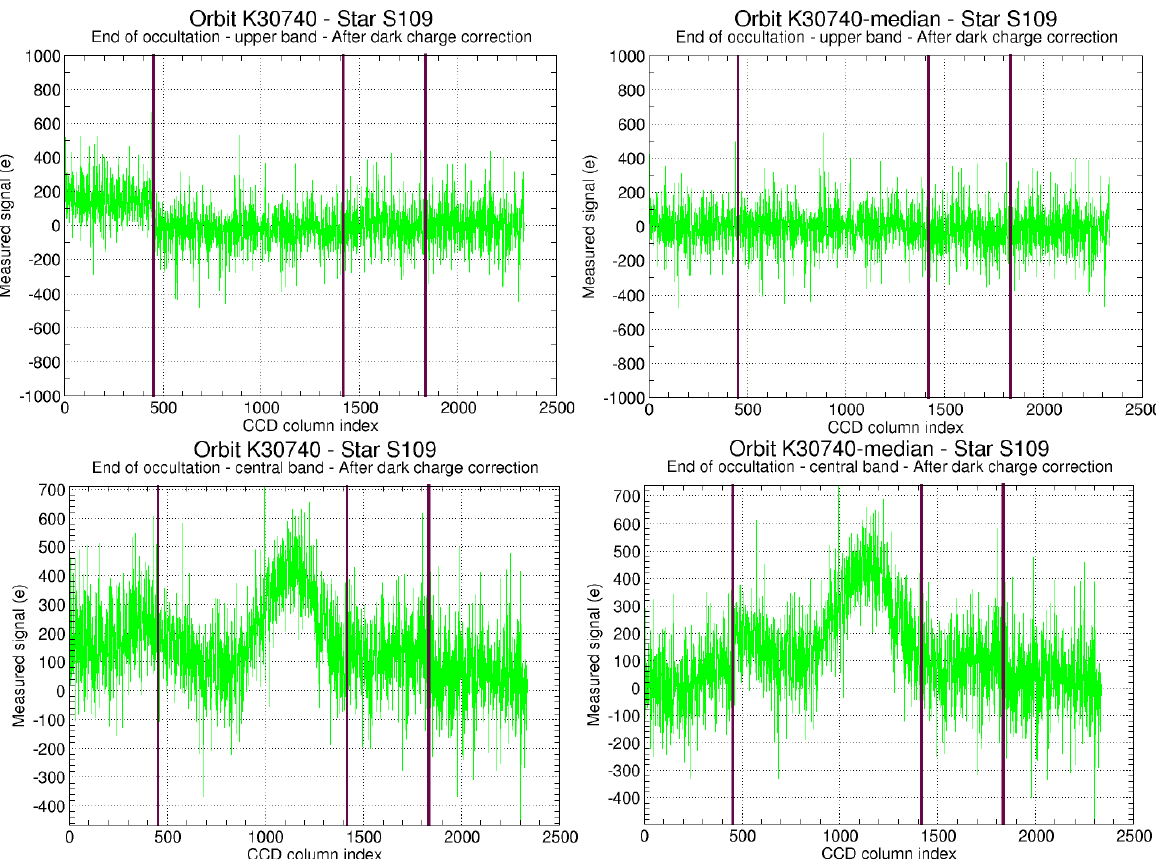
Fig. 2. Dark charge bias correction using two methods and the respective star spectra with noise extraction. Noise estimated for “Dark Sky Area” method GOPR v6.0cf (top left). Example of star spectrum with noise extraction in v6.0cf (bottom left). Noise estimated with side CCDs GOPR v7.0ab (top right). Example of star spectrum with noise extraction in GOPR v7.0ab (bottom right). Vertical black bars indicate the various CCDs. The x-axis indicates the CCD column index. 0 to 445 covers the UV part, 248 to 400nm; 446 to 1415 covers 675 to 400nm in reverse order); then from 1416 to 1838 there is the CCD devoted to the O 2 band around 760nm, and the one devoted to H 2 O around 936nm, from 1839 up to pixel